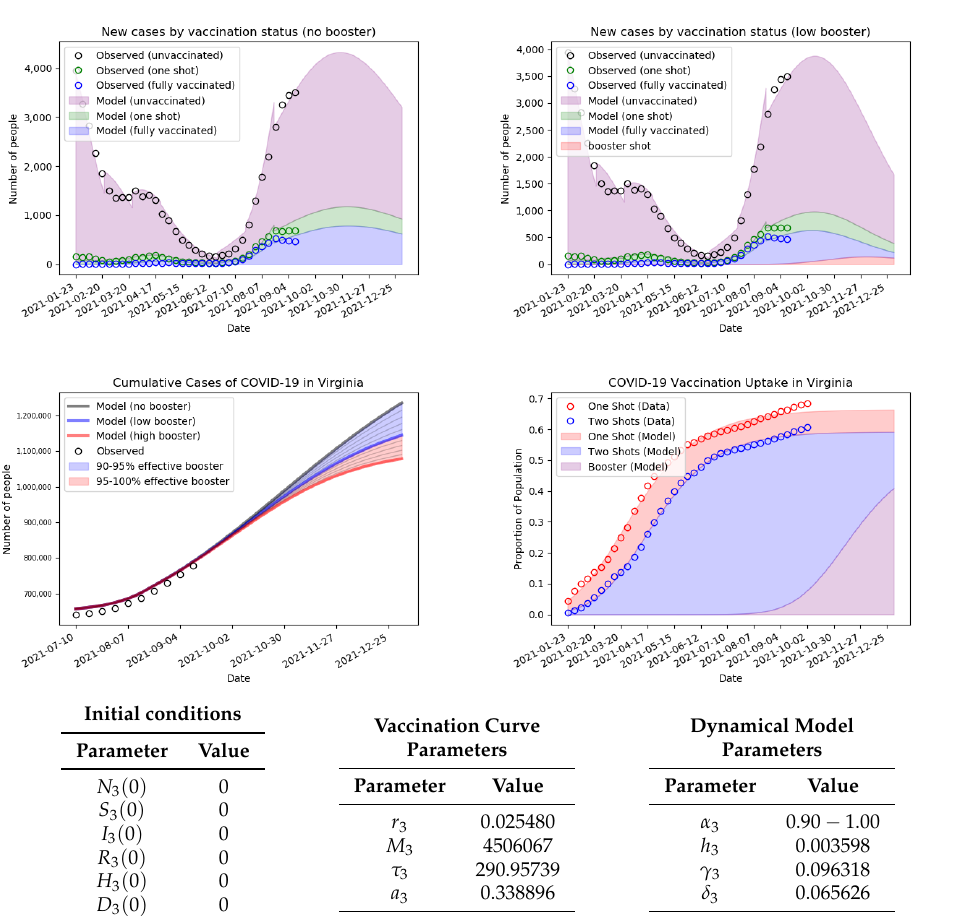
Figure 5. Simulations of the three-stage vaccination model (2) with j = 3 corresponding to individuals who have received a booster shot. The parameters for the booster shot uptake curve V 3 ( t ) are shown, and the parameters for the vaccination uptake curves V j ( t ) , j = { 0,1,2 } , are from Table 2. The reductions in the baseline transmission parameter for the booster shot are α 3 = 0.95 (low booster) and α 3 = 1.00 (high booster) [39,40], and the model runs from 23 January through 31 December